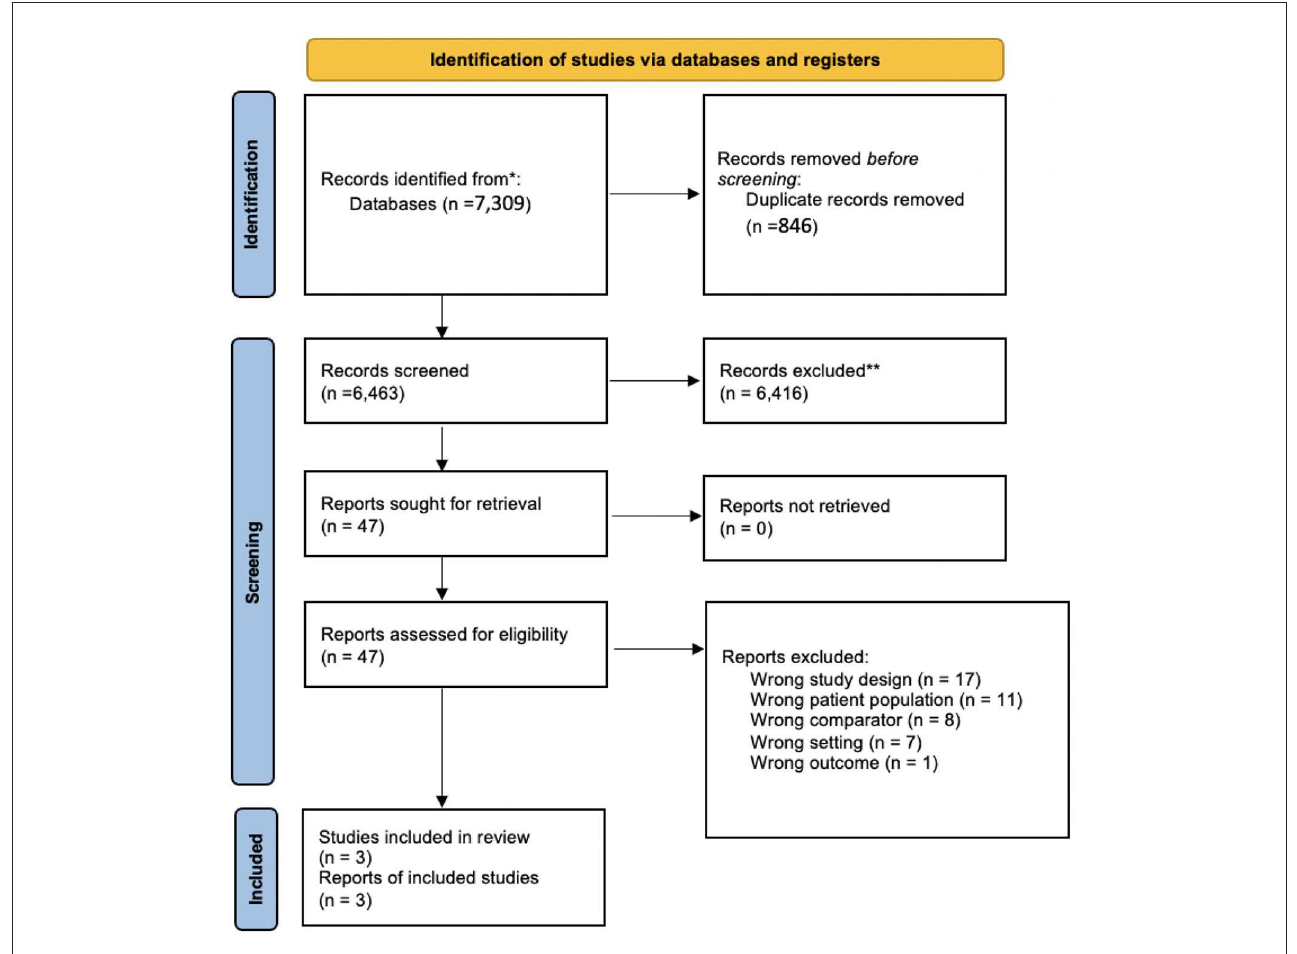
FIGURE1 Flow chart of the study selection generated by